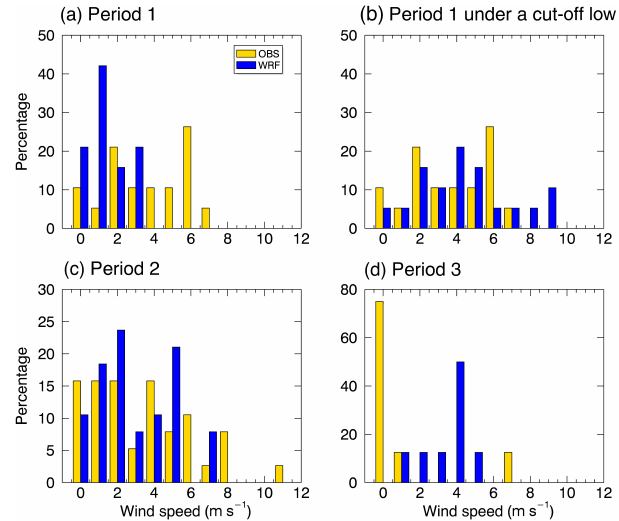
Figure 7. Histograms of observed and simulated surface wind speed for period 1 (a) , period 2 (c) , and period 3 (d) . Panel (b) shows the wind histogram of 23 October with an upper-tropospheric cut-off low system. Model results are sampled at the same time and location as the observations. In (b) , the date information is not used. Wind speed is binned at a 1ms − 1